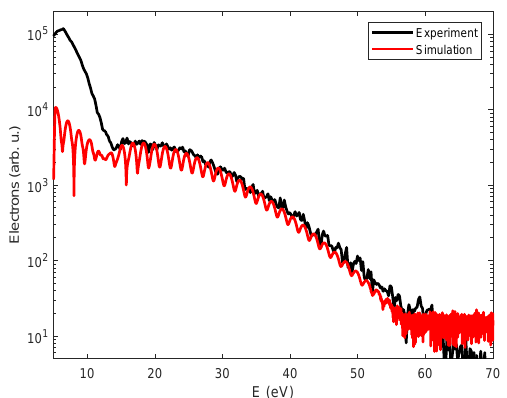
Figure 6. A comparison of experimental [15] and simulation data. While both scaling by a constant and exponentiating the data, we arrive at plots that largely agree in the plateau regime. Note that the energy axis is only translated, not scaled, to account for the bias voltage in the